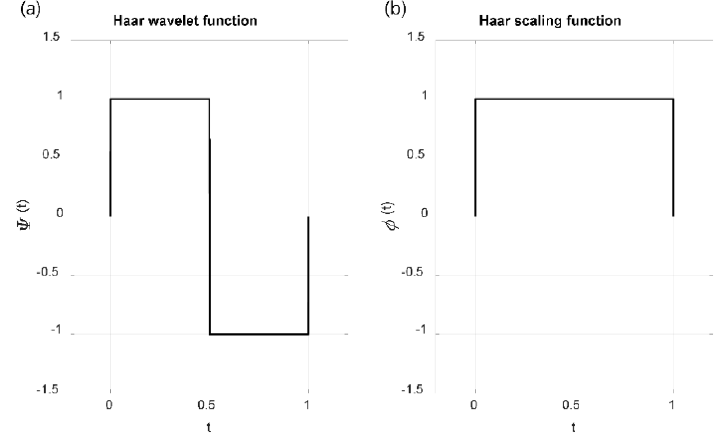
Figure 2. Haar wavelet, wavelet function ( a ) and scaling function ( b ).